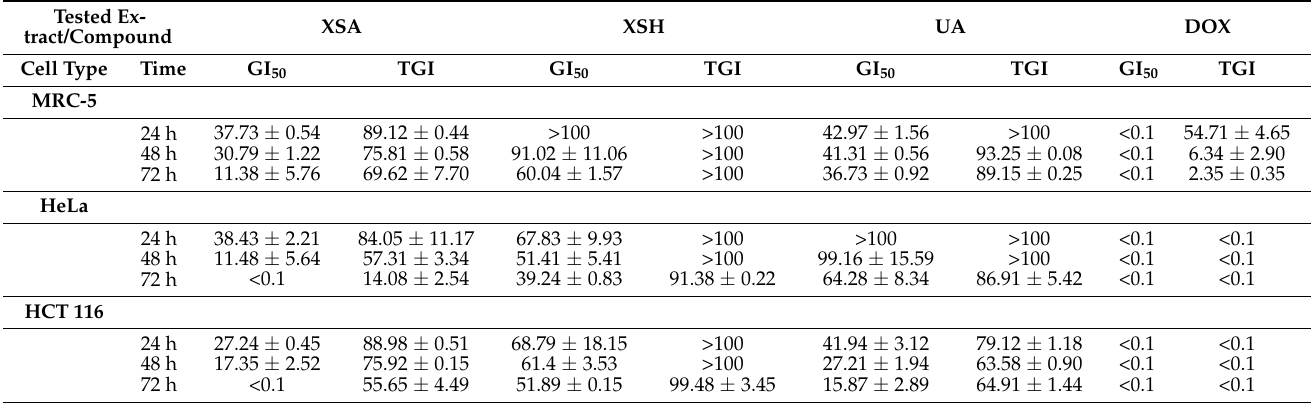
Table 10. XSA, XSH, UA, and doxorubicin concentrations ( µ g/mL) were needed for 50% growth inhibition (GI 50 ) and total growth inhibition (TGI) of MRC-5, HeLa, and HCT 116 cells after 24, 48, and 72 h